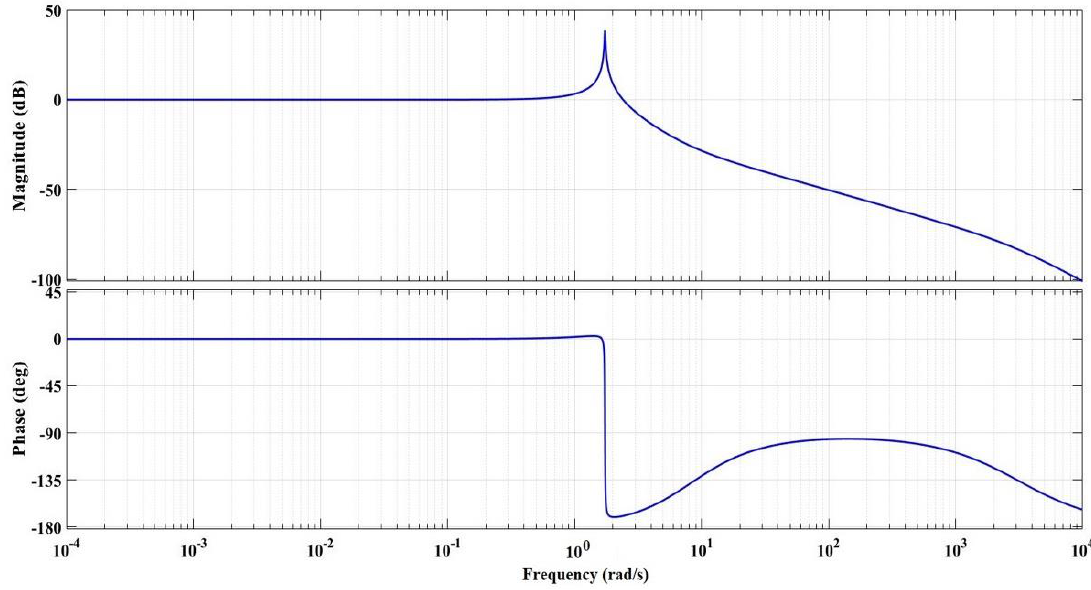
Figure 7. Bode diagram for the closed-loop control system for the power electronic converter using an FO lead-lag controller.